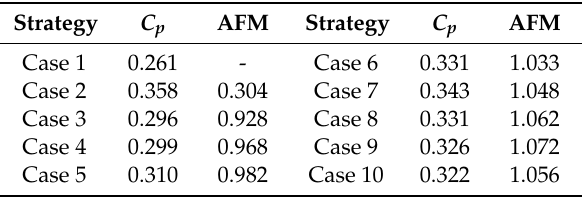
Table 4. C p and AFM at plasma actuation.